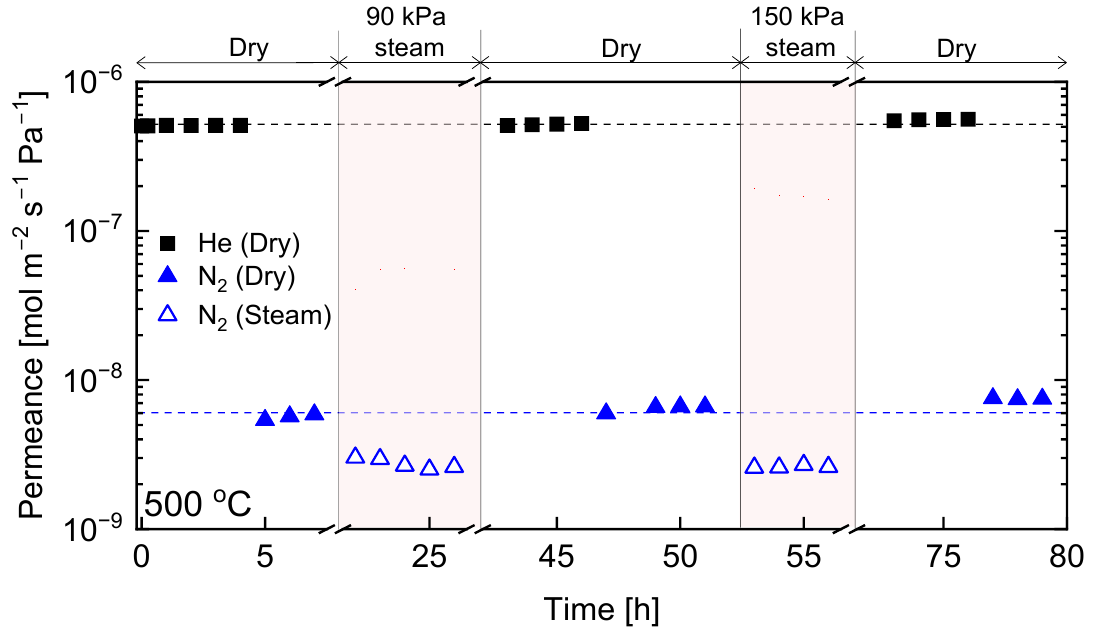
Figure 10. Time courses for hydrothermal stability tests at 500 °C in a mixture of H 2 O+N 2 (90 and 150 kPa of steam partial pressure; total pressure of 300 kPa) for carbon-SiO 2 -ZrO 2 membranes pre- pared at 750 °C.